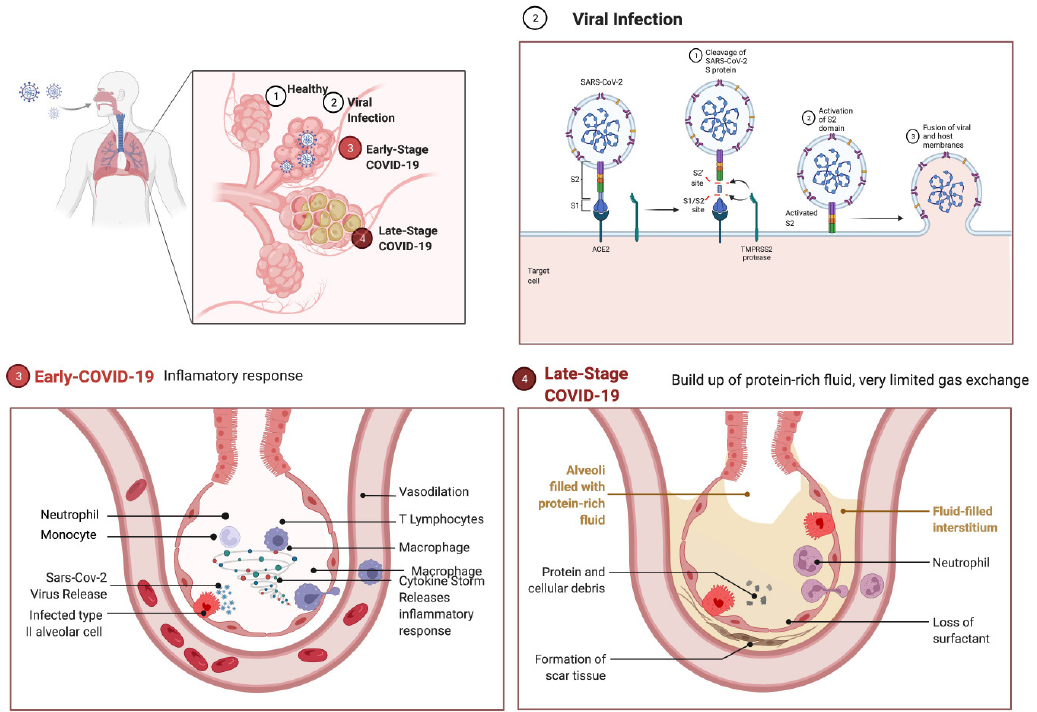
Figure 4. Schematic representation of SARS-CoV-2 viral infection. Upper left panel a representation of the bronchi in healthy, during viral infection, early-stage infection and late-stage infection. The right upper panel displays a schematic representation of SARS-CoV-2 viral spike protein and the cleavage sites for furin and TMPRSS2. The lower left panel represents the early stages of infection, where the macrophages are recruited and cause the cytokine storm as a result. The lower right panel represents the late-stage of COVID-19 infection where there is a protein-rich fluid inside the alveoulus, triggering the alveolar collapse which in turn decreases the gas exchange. Neutrophils are also recruited to destroy the cells that have been infected, which could also lead the ARDS. Created with